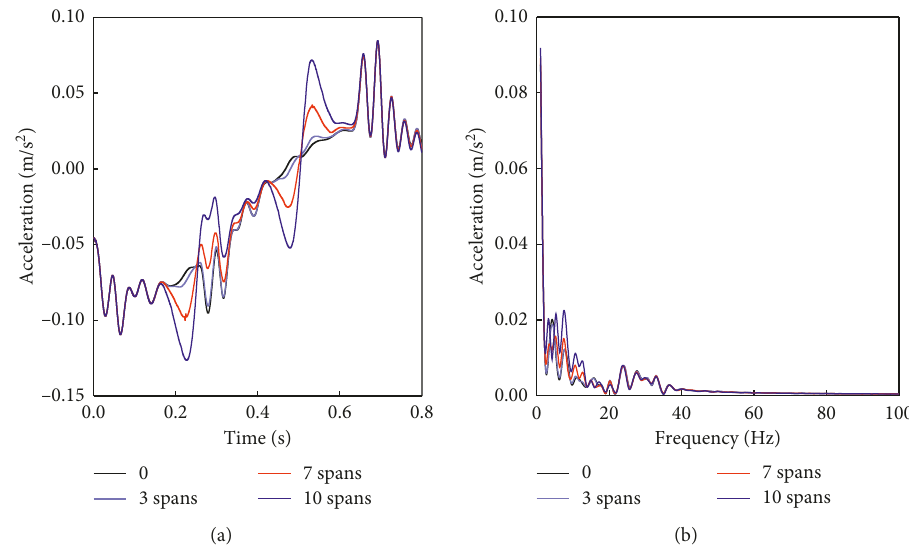
Figure 10: Vehicle acceleration with different lengths of contact loss zone: (a) time domain and (b) frequency domain.